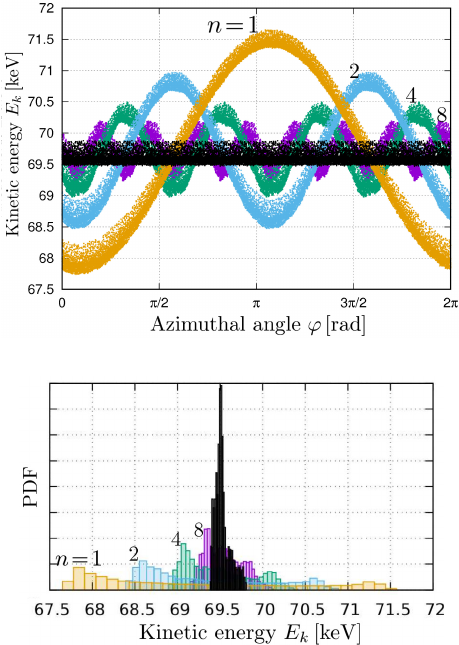
Figure 5. Kinetic energy of the beam electrons at top and the kinetic energy distribution for several values of inhomogeneity harmonic n at